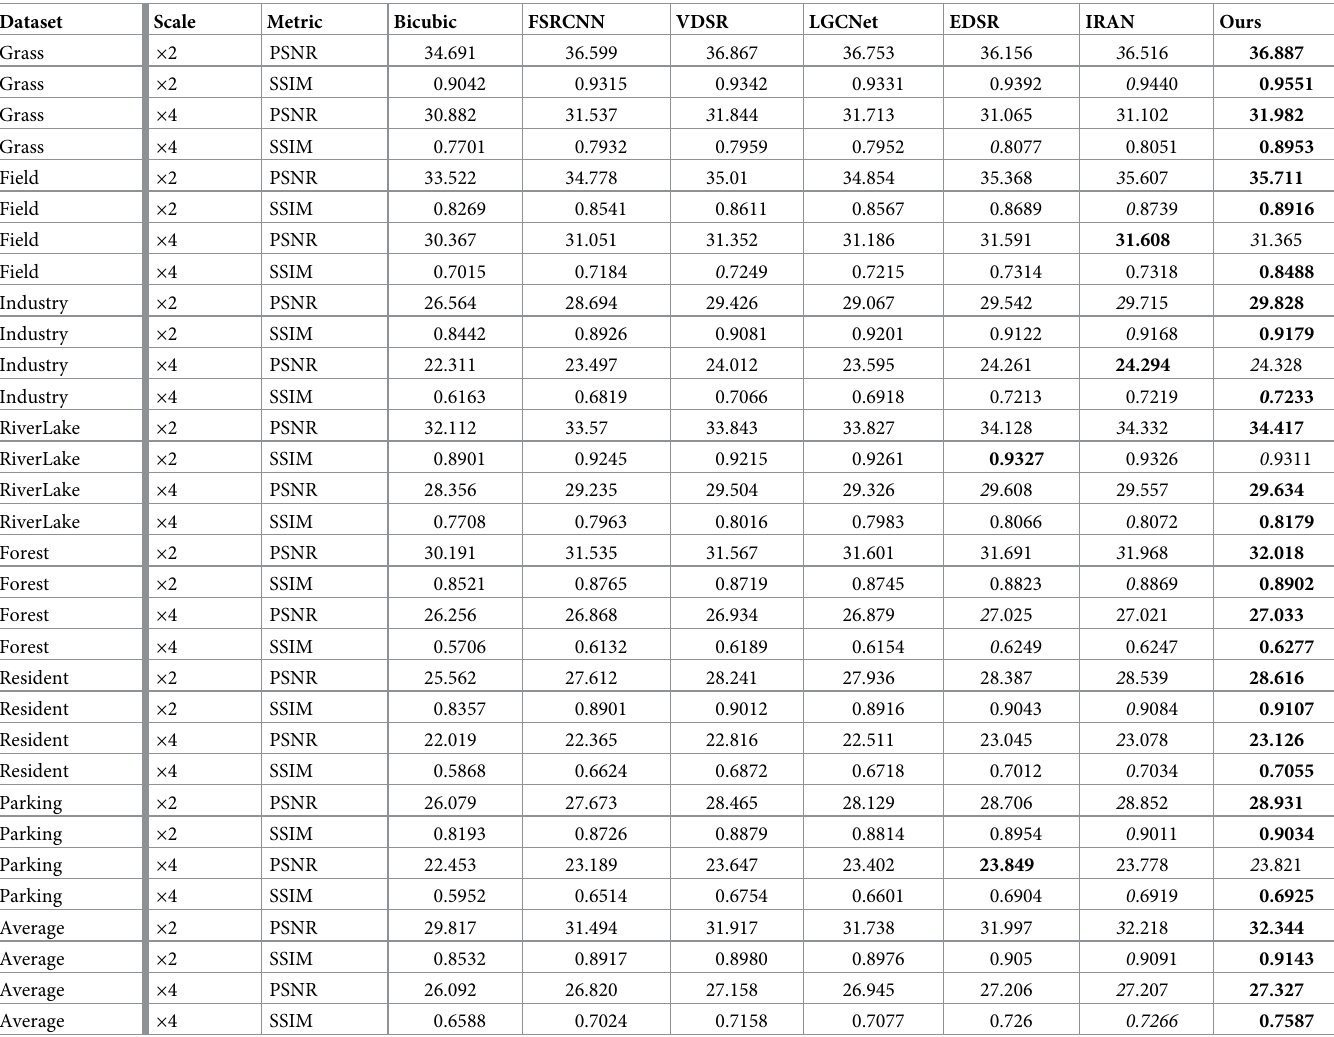
Table 2. PSNR and SSIM comparison results among different methods. Boldface indicates the best performance and italics indicate the second-best performance.